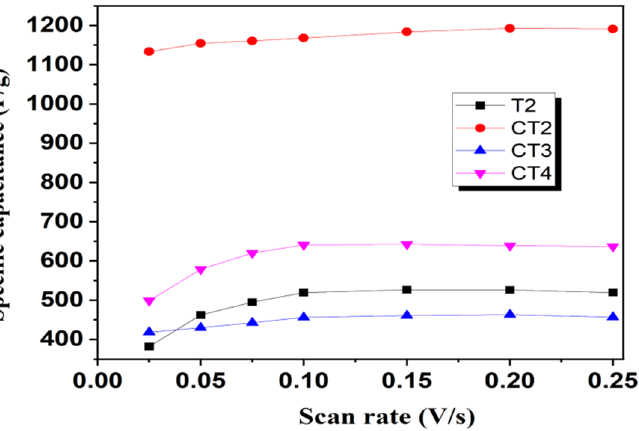
Figure 7. The evolution of specific gravimetric capacitance at the different scan rates for pure TiO 2 and Cu-doped TiO 2 composites. Table 3. Data obtained from cyclic voltammetry and galvanostatic charge–discharge curves for pure TiO 2 and Cu-TiO 2 electrodes.